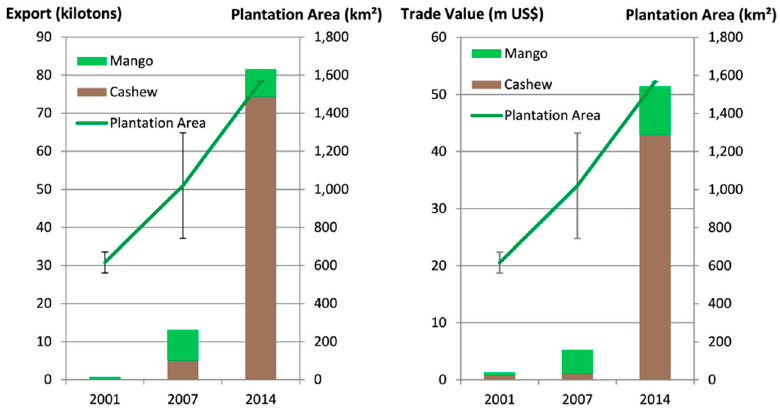
Figure 14. Amount ( left ) and trade value ( right ) of exported cashews and mangos from Burkina Faso as well as the total observed plantation area for the years 2001, 2007, and 2014; error bars describe the possible range of plantation area due to data gaps in the classifications [34].